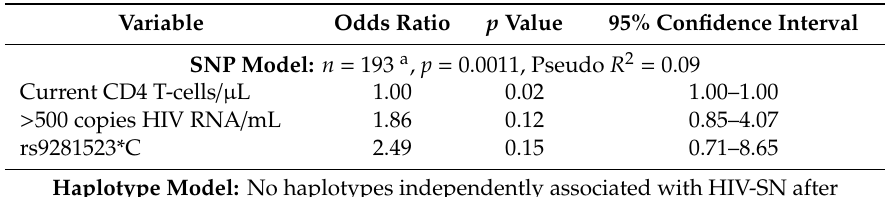
Table 3. Logistic regression modelling identified rs9281523*C in Indonesians as an independent marker of susceptibility to HIV-SN.